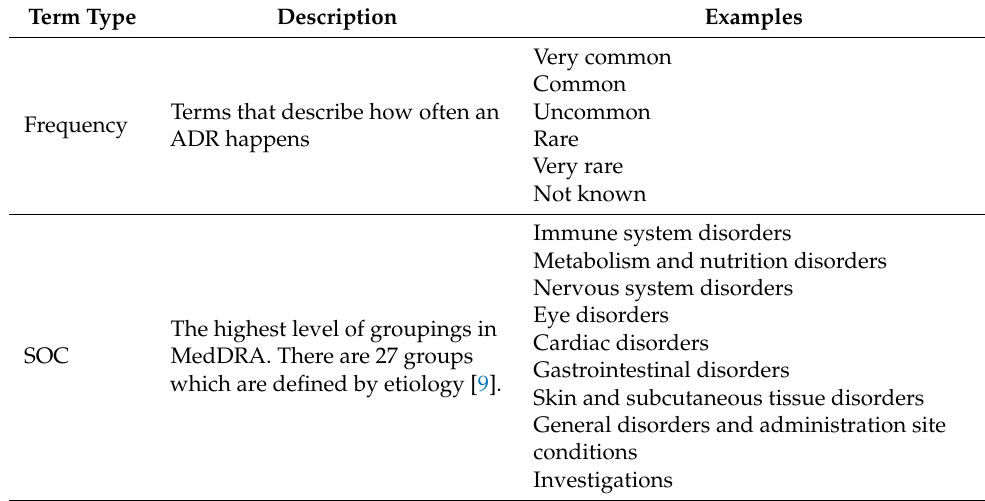
Table 1. Examples of ADR-specific terminologies.